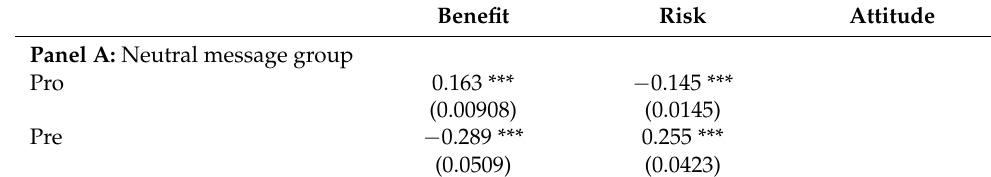
Table 3. The structural model of cultured meat (standardized coefficients).